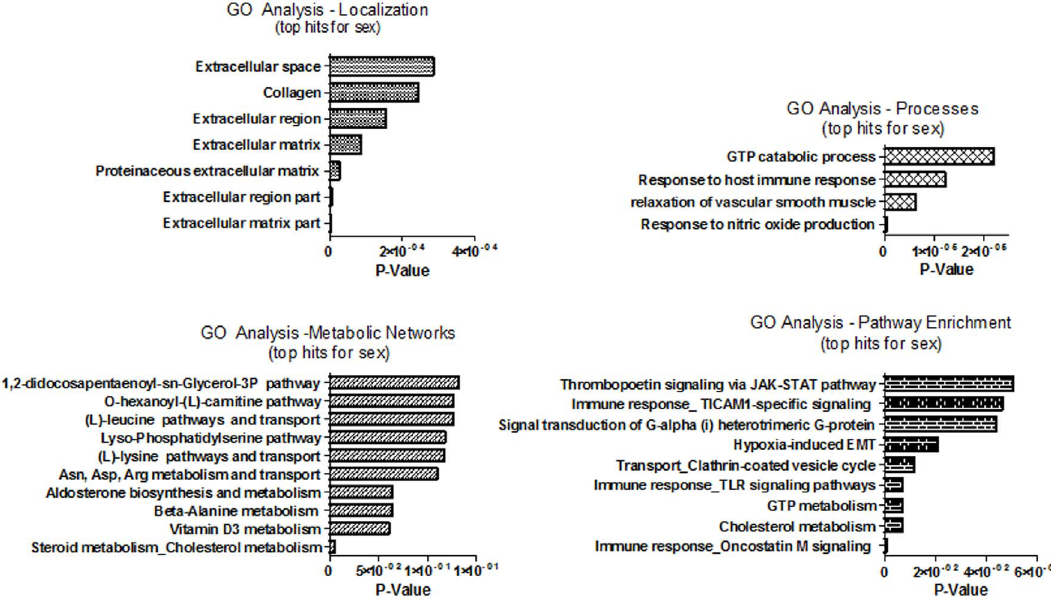
Figure 5. GO Enrichment Analysis for top hits of sex significant Genes: GO Term analysis were performed using MetaCore from GeneGo on the list of significant genes varying by sex, FDR , 0.05. Top 10 hits (where applicable) are presented for (A) Localization, (B) Cellular Processes, (C) Metabolic Networks, and (D) Pathway Enrichment. P values are calculated based on hypergeometric distribution. The P-values on the graph indicate the probability of mapping of an experiment to a process to arise by chance.